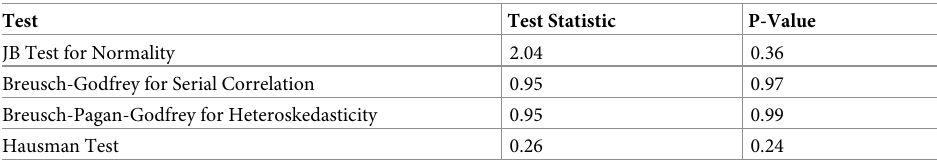
Table 7. Autocorrelation, heteroscedasticity & endogeneity test